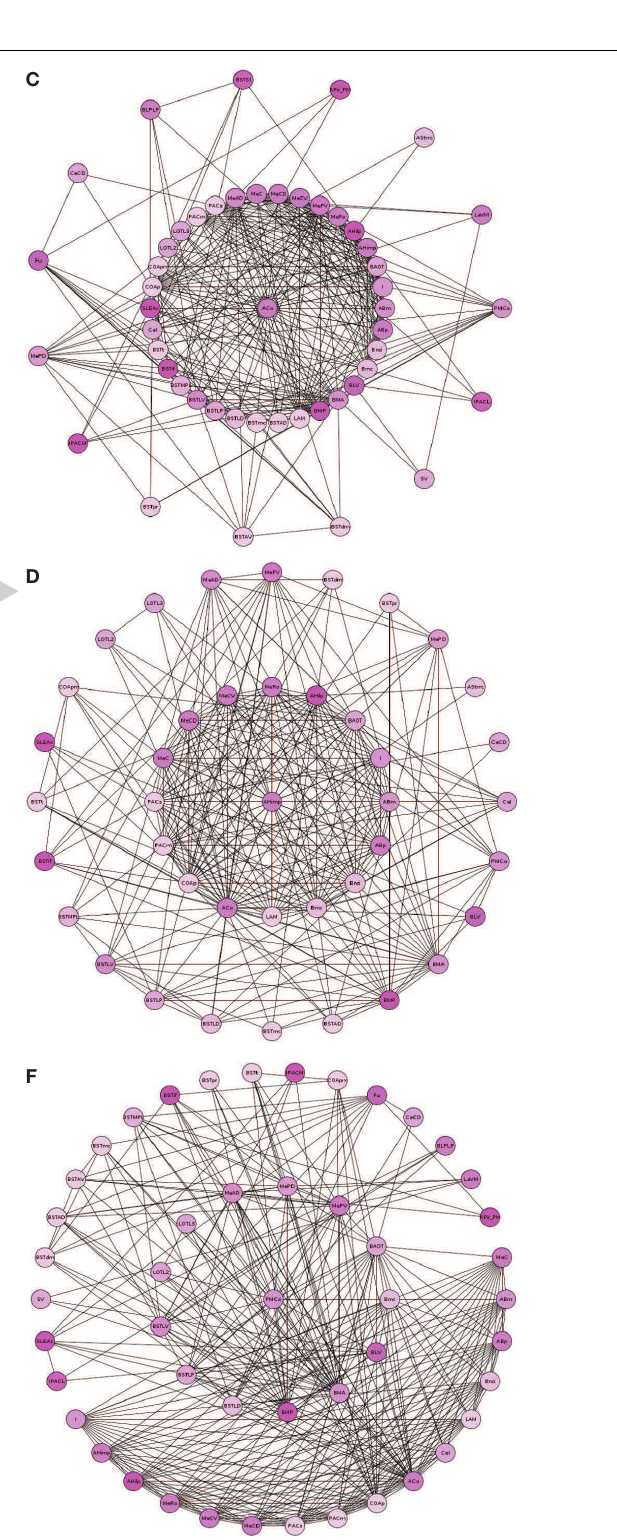
The inner-ring of circles are the 1st neighbors and the outer-ring of circles are the 2nd neighbors of the center region. (B) Subventricular nucleus (SV). (C) Anterior cortical nucleus (ACo). (D) Amygdalohippocampal area medial part (AHimp). (E) Posteromedial cortical nucleus (PMCo). (F) Amygdalostriatal transition area rostrocaudal